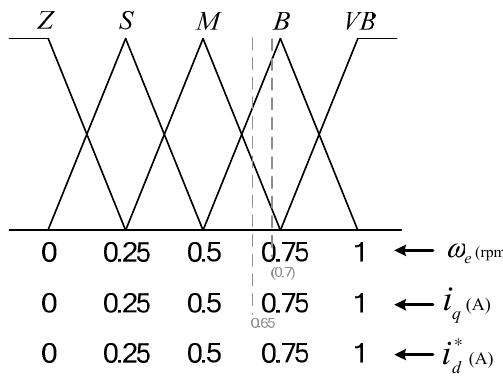
Figure 4. Fuzzy control based MTPA ( a ), and MTPV ( b ).